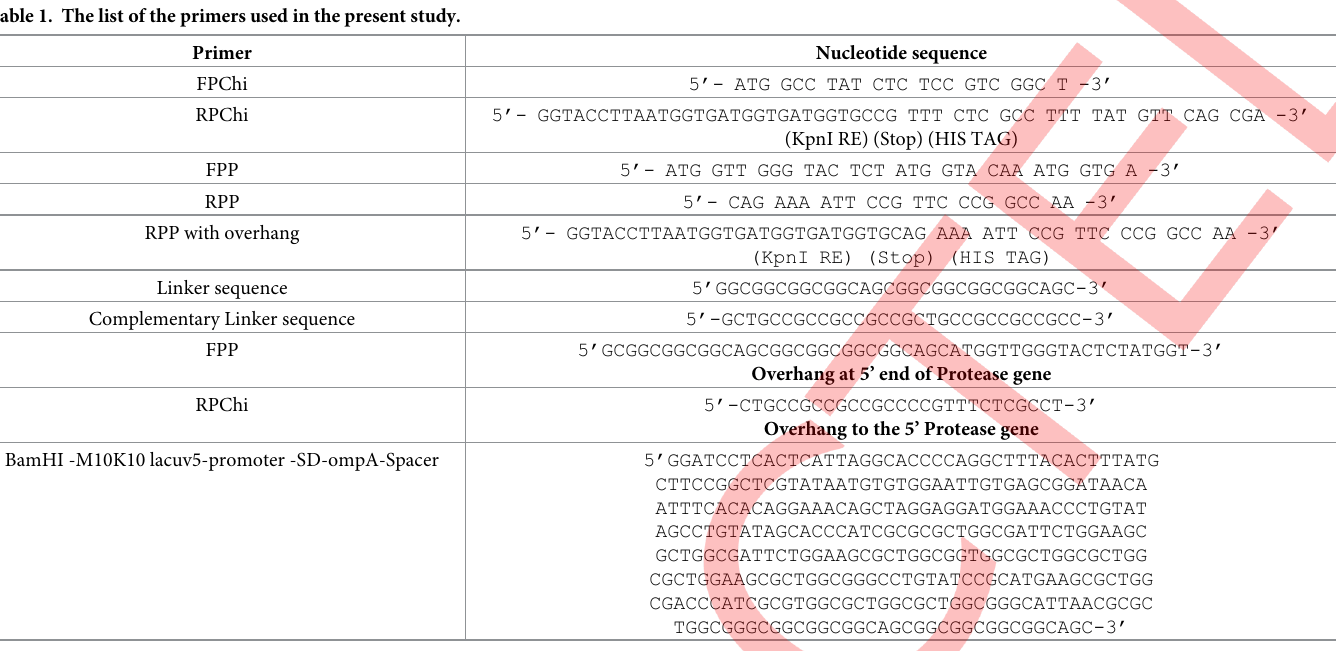
Table 1. The list of the primers used in the present